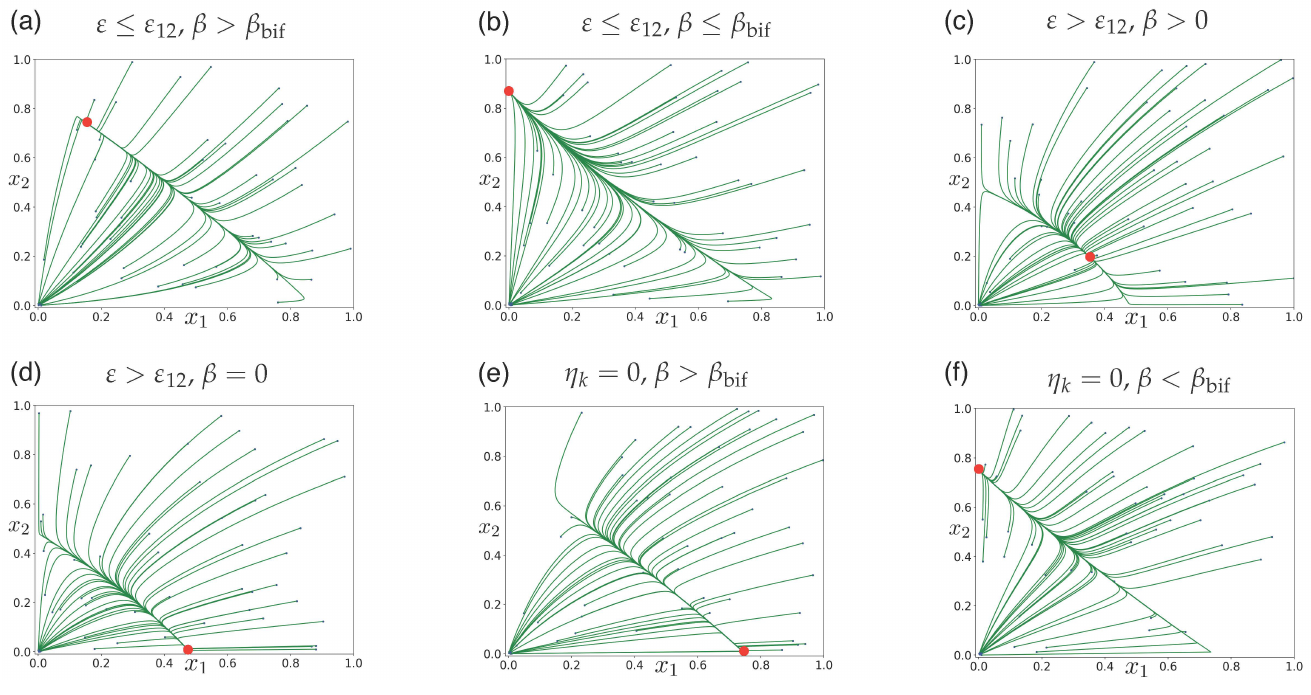
Figure 6. Phase portraits of the system in the qualitatively different identified situations. Specifically, we have used: ( a ) ε = 0.13, ε 12 = 0.72, β = 0.9, η k = 1.7; ( b ) ε = 0.13, ε 12 = 0.72, β = 0.25, η k = 1.7; ( c ) ε = 0.52, ε 12 = 0.22, β = 0.55, η k = 0.8; ( d ) ε = 0.52, ε 12 = 0.22, β = 0, η k = 0.8; ( e ) ε = 0.25, ε 12 = 0.49, β = 0.8, η k = 0; ( f ) ε = 0.25, ε 12 = 0.49, β = 0.14, η k = 0. Again, a red dot indicates the ω limit of each orbit and a blue dot its initial −